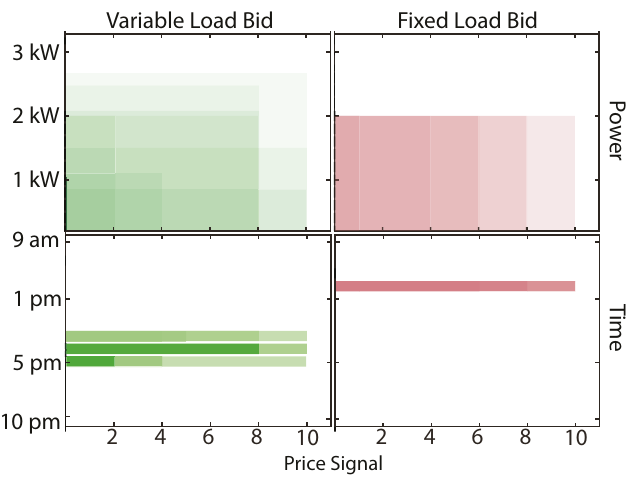
Fig. 8. Bid generated without nvParam by Flexometers and their turn ON timings during demonstration with respect to price signals.